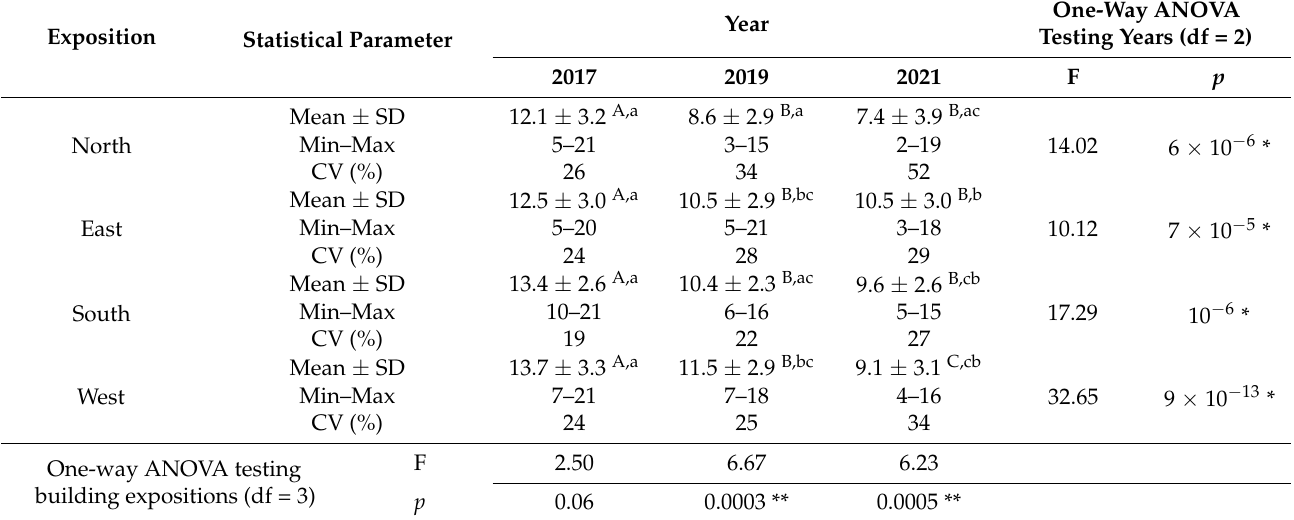
(Table 2). The mean number of species stopped declining by the last year of observation on the east exposition, but a slight downward tendency remained in the segments on the north, south, and west expositions (Table 2). In all the expositions of the building, the number of species in the segments varied within very wide limits, and the increasing coefficients of variation over the years indicate this enduring tendency (Table 2). Table 2. Descriptive characteristics of the number of plant species in the investigated segments of the vertical columns, as well as a one-way analysis of variance (ANOVA) examining years and building expositions according to the number of plant species in the segments (CV—coefficient of variation (%); SD—standard deviation; df—degree of freedom; F—Fisher criterion; p —statistical significance; *—significant differences between years ( p < 0.05); **—significant differences between expositions of the building ( p < 0.05). Letters denote statistically significant ( p < 0.05) differences: capital letters—between the years in each exposition, lower letters—between expositions each year).